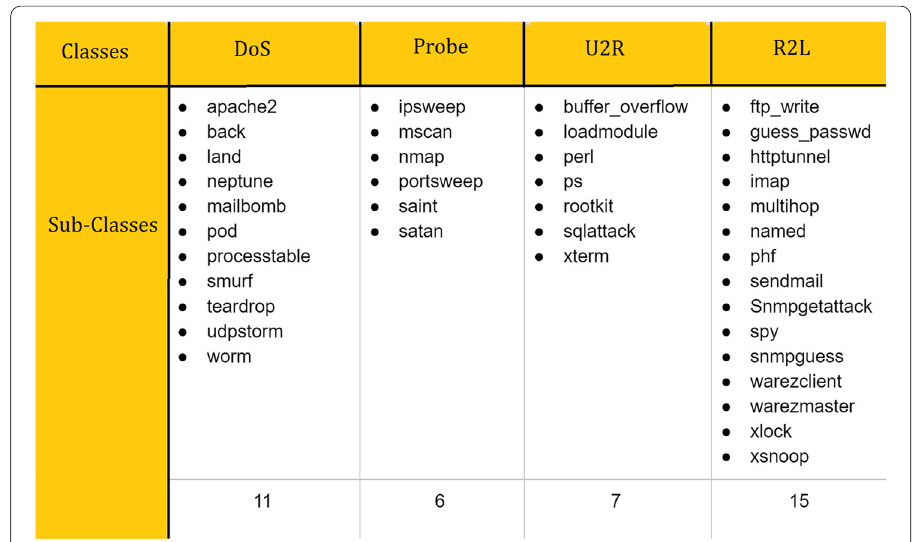
Fig. 5 Different subclasses of each attack that exists in the data